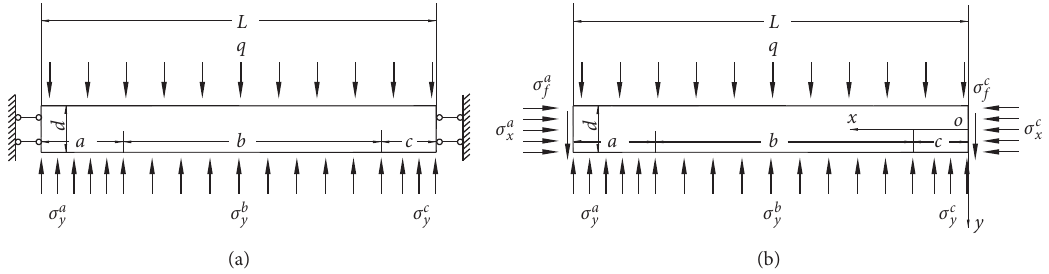
Figure 4: Mechanical model of sliding-rotating beam. (a) Sliding-rotating beam. (b) Force analysis of sliding-rotating